Question: Express in one sentence what the figure is showing.
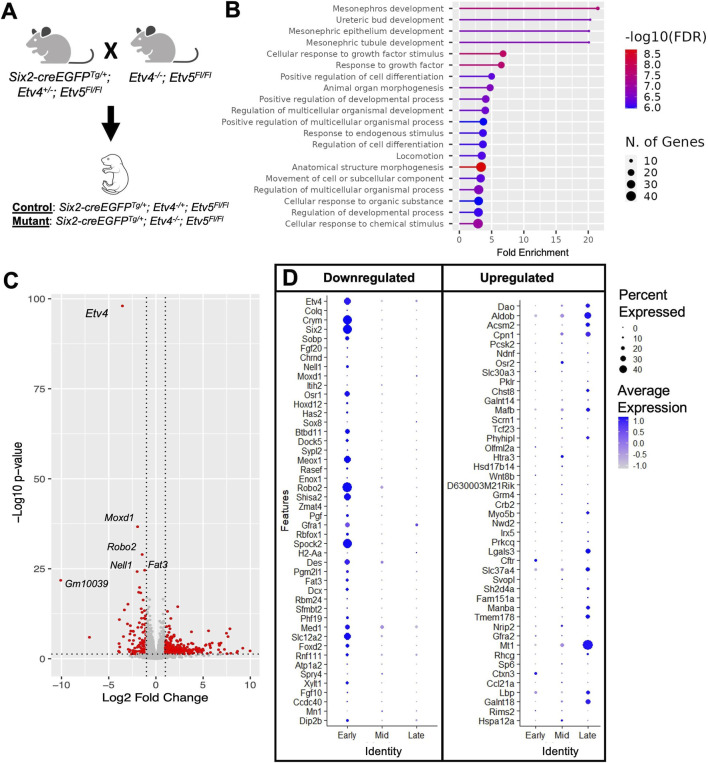
Answer: Disrupting the Etv4 and Etv5 expression alters the transcriptome. (A) Mating strategy for samples used in RNA-Seq analysis. (B) ShinyGO GO biological process analysis ( Ge et al., 2020 ) for RNA-Seq results highlights the disruption to nephrogenesis, kidney development and pathways that are known to be related to ETV4 and ETV5 functions. (C) The volcano plot with a selection of the most significantly altered genes highlighting possible downstream targets for Etv4 and Etv5 . (D) Plot showing the top 50 most downregulated and upregulated genes in the Six2-cre mutants mapped against 3 distinct developing kidney scRNA-Seq clusters- “early”, “mid” and “late” (scRNA-Seq data from Combes et al., 2019 ). The downregulated genes in the Six2-cre mutants align with “early” developmental clusters while the upregulated genes align with the “late” nephron segment clusters.